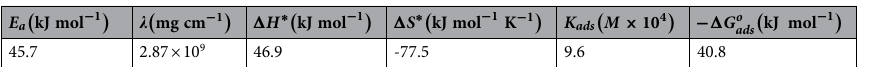
E a (cid:31) kJ mol − 1